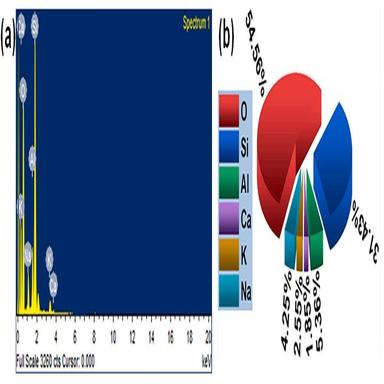
EDS analysis of NQNs; (a) EDS spectrum showing the presence of O, Si, Al, Ca, K, and Na, and (b) pie chart representing the weight ratios of these elements.